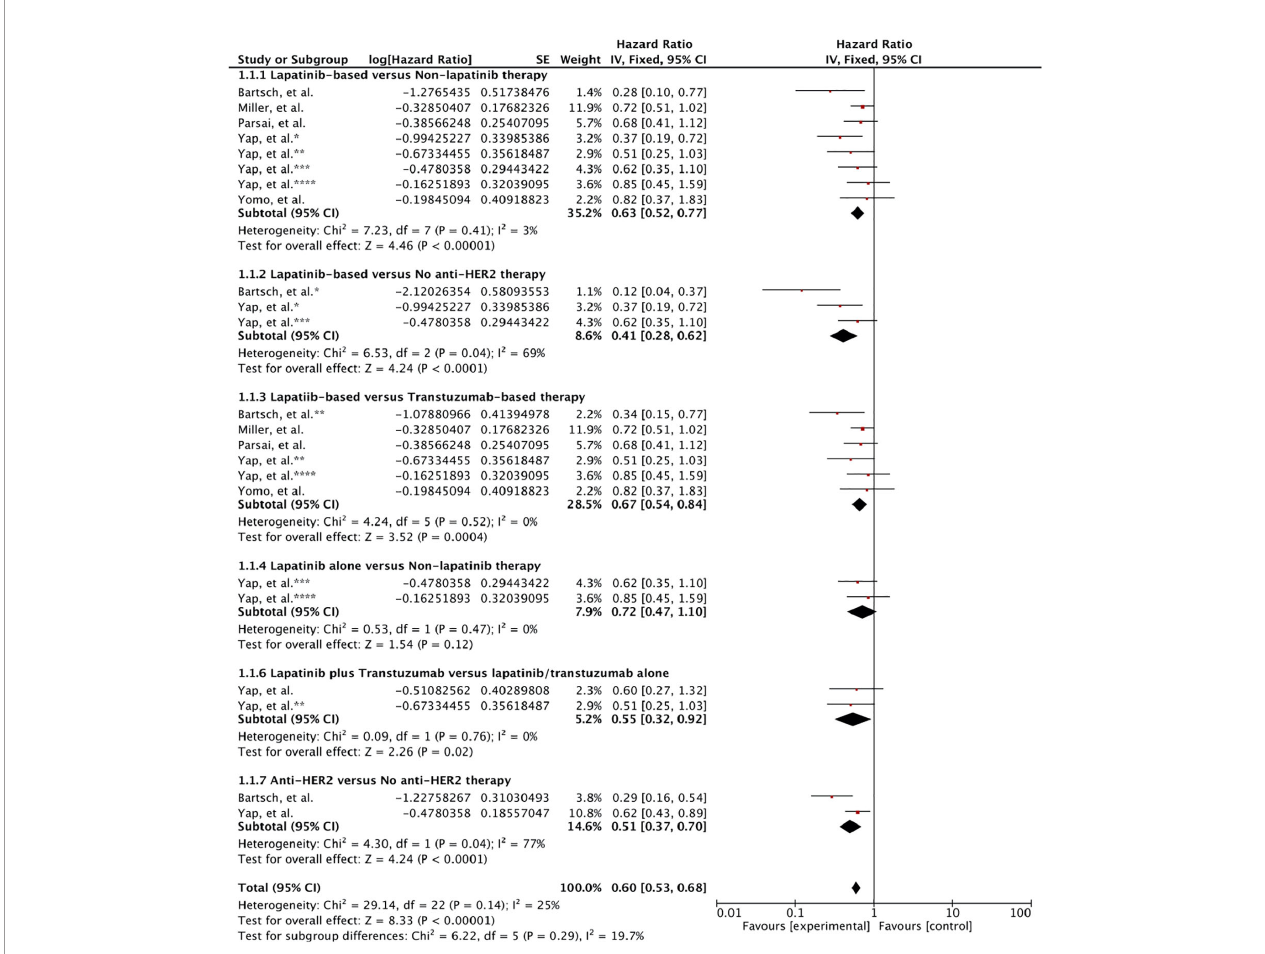
FIGURE 2 | Forest plot of meta-analysis of overall survival (OS) for treatment comparison (Lapatinib versus non-lapatinib-based therapy) in the management of brain metastases from HER-2 positive breast